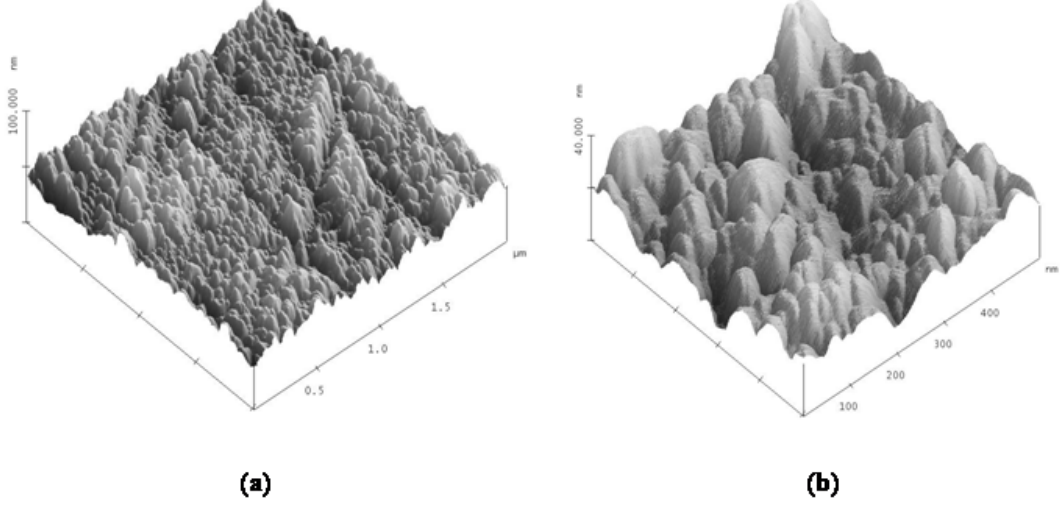
Figure 2. The atomic force microscopy (AFM) images of the SDS molecules deposited on Ge substrate using the technique are presented at ( a ) 2 × 2 μ m 2 and ( b ) 500 × 500 nm 2 resolutions. The z -axis refers to the depth used to estimate the